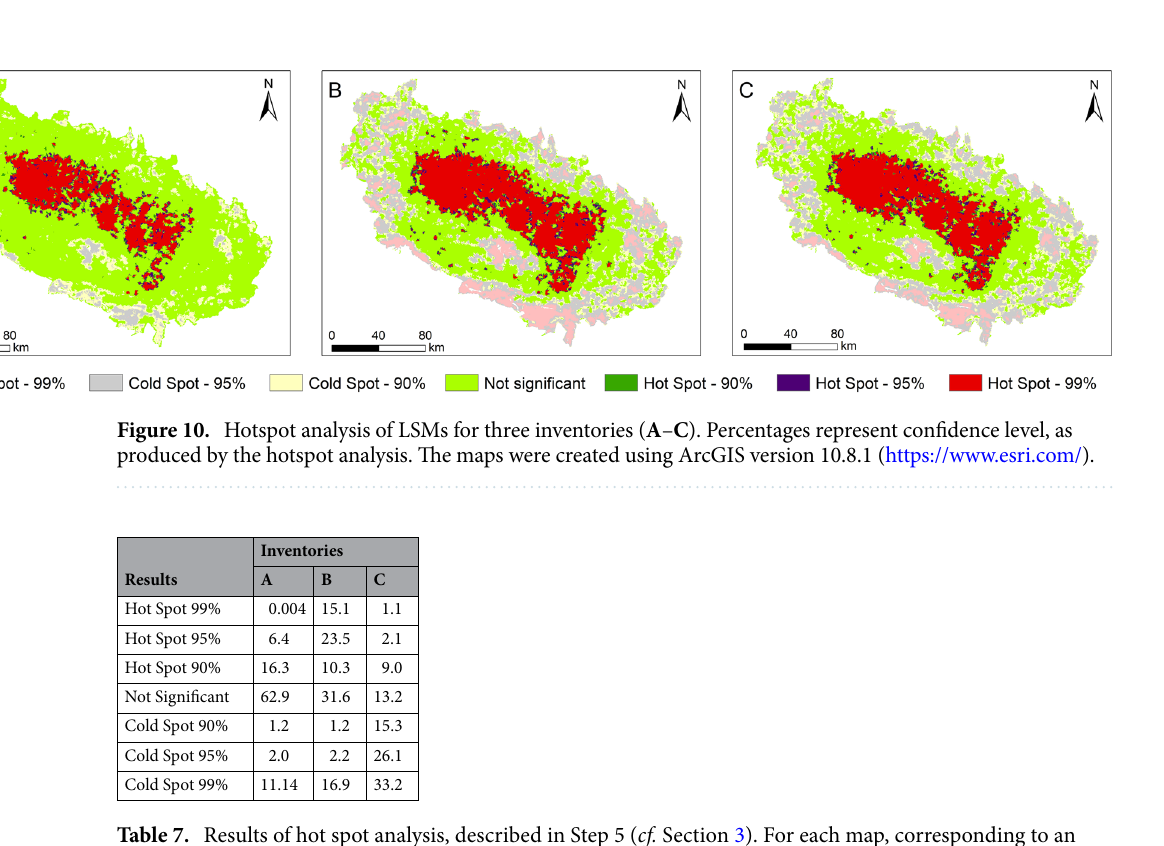
Table 7. Results of hot spot analysis, described in Step 5 ( cf. Section 3). For each map, corresponding to an individual inventory, we list the percentage of slope units in each hot spot class. The percentages in the “Result” column represent the confidence